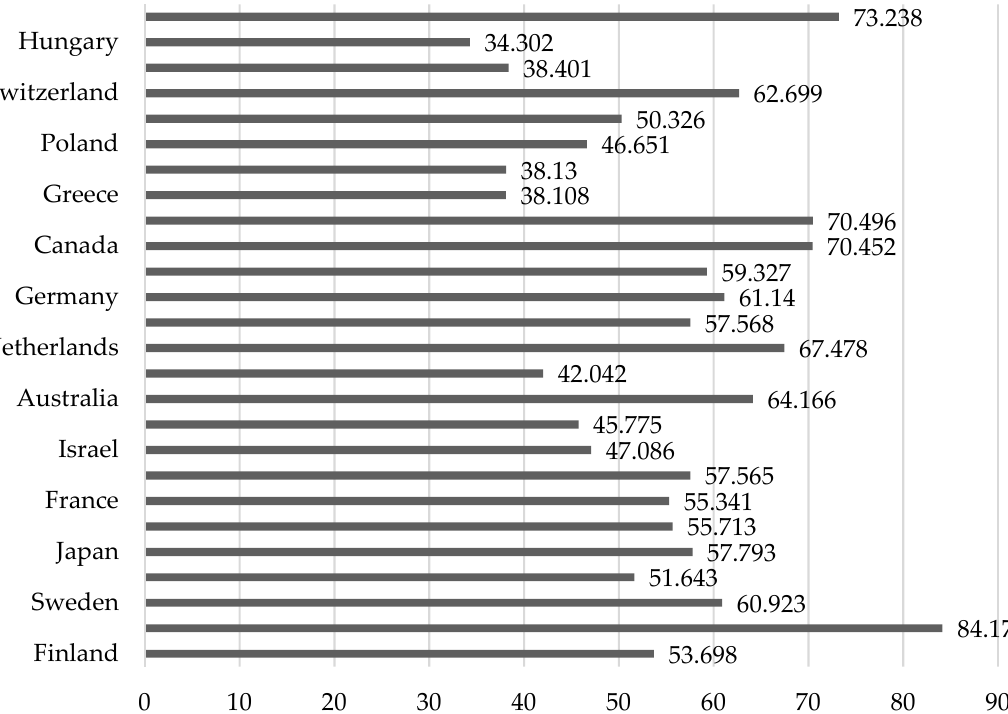
Figure 2. Social entrepreneurship index (SEPR) in developed economies of the sample in 2021 (as a result of 2020), points 1–100. Source: Compiled by the authors based on data from the Institute of Scientific Communications (2021).